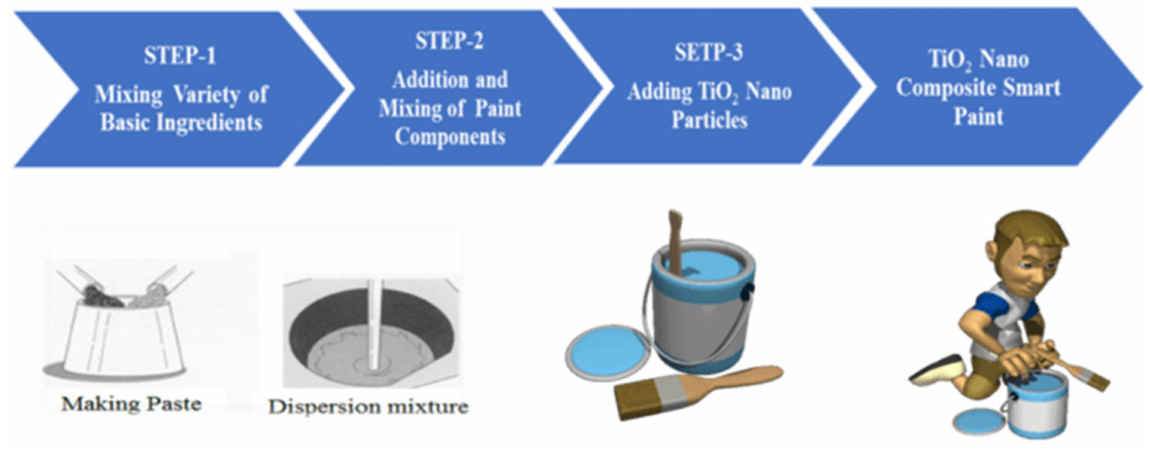
Figure 7. Schematics of steps involved in formulation of nanocomposite paint. Islam et al. reported the development of photocatalytic paint based on TiO 2 and photopolymer resin for the degradation of organic pollutants in water. Photocatalytic paint (consisting of a mixture of TiO 2 and photopolymer resin) with a different